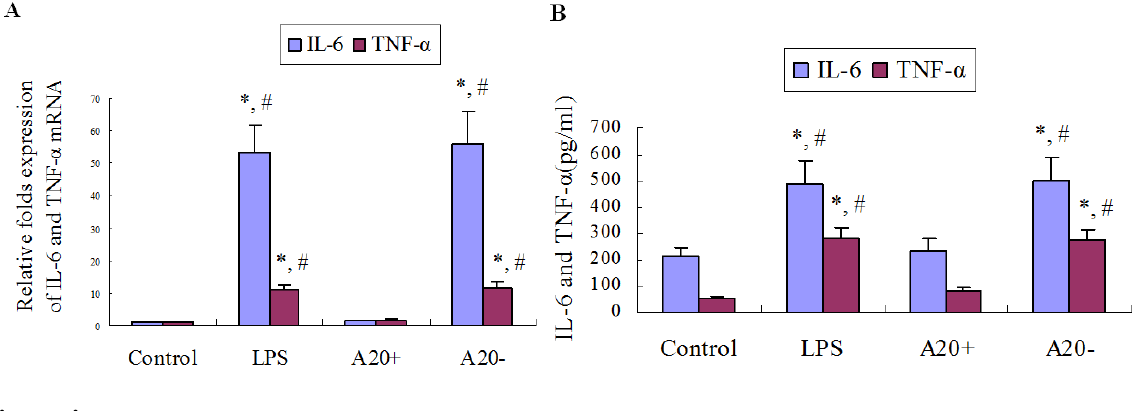
Figure 6. Effects of A20 on LPS-induced IL-6 and TNF- α expression in RPMCs. Cells were pre-transfected with pGEM-T easy- A20 or pGEM-T easy for 24 h. Cells incubated with serum-free DMEM/F12 alone were used as the control. Near confluent cells were cultured in serum-free medium for 24 h to arrest and synchronize cell growth and then exposed to LPS (1 μ g/mL) for 24 h. RT-PCR and ELISA were performed to determine IL-6 and TNF- α mRNA expression as well as IL-6 and TNF- α protein levels in culture supernatants, respectively. ( A ) Bar graph shows the expression of IL-6 and TNF- α mRNA. Results were obtained from three independent experiments. Data are presented as the mean ± SD ( n =